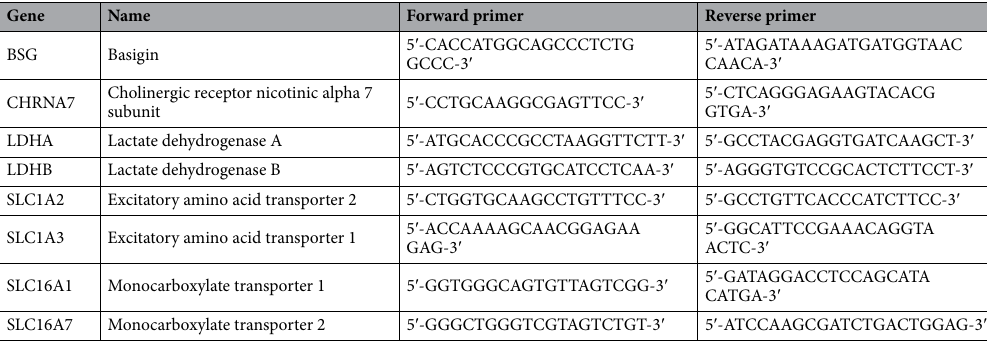
Table 2. mRNA primers. Forward and reverse primers used for RT-PCR are listed for each